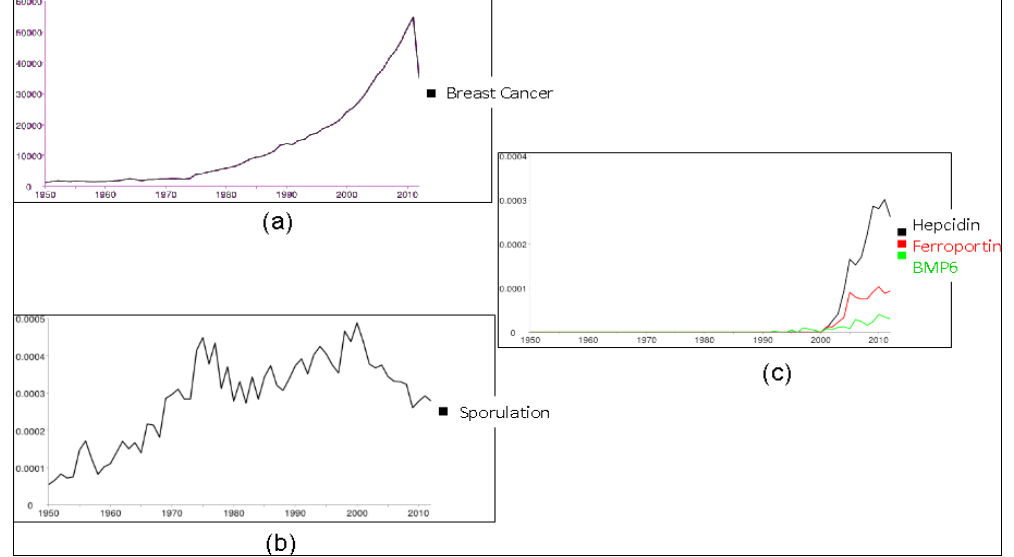
Figure 2. Keyword Trends over time in Medline using